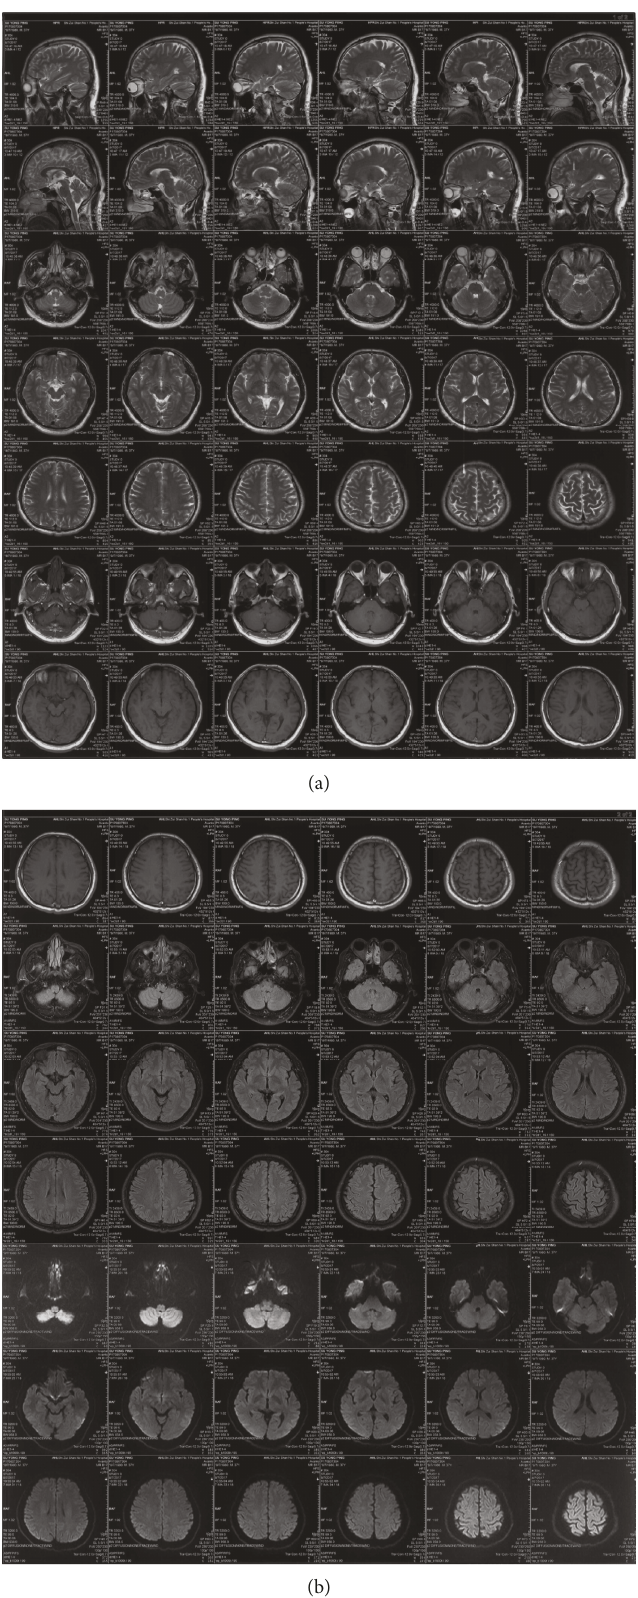
Figure 8: Preoperative head nuclear magnetic resonance